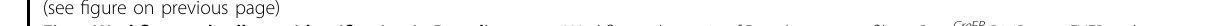
Fig. 1 Work fl ow and cell type identi fi cation in Pax7 lineage. a Work fl owschematicofPax7 lineage pro fi ling. Pax7 CreER :R26R-stop-EYFP embryos were induced with tamoxifen on E9.5, and harvested on E12.5, E14.5, and E16.5. Progenies of Pax7 + progenitor cells were enriched and sorted by YFP signal. YFP + cells were prepared for sequencing using either Smart-seq2 or 10× protocol, followed by bioinformatic analysis. b Uniform manifold approximation and projection (UMAP) of YFP + cells from Pax7 CreER :R26R-stop-EYFP embryos on E12.5, E14.5, and E16.5. Two datasets from Smart-seq2 and 10× protocol were integrated using scVI for visualization and analysis. Cells were labeled by harvest time of embryos. c UMAP of YFP + cells from Pax7 CreER :R26R-stop- EYFP embryos on E12.5, E14.5, and E16.5. Cells were clustered by unsupervised clustering and were named by identity based on gene expression pro fi le. EP, earlyprogenitor;LP, lateprogenitor; EM, early muscle; LM, latemuscle; BA, brown adipocyte; DF, dermal fi broblast;N,neuron; PE, Pericyte. d Dot plot of gene expressions that were used to identify clusters. Each row corresponds to the marker genes for different cell